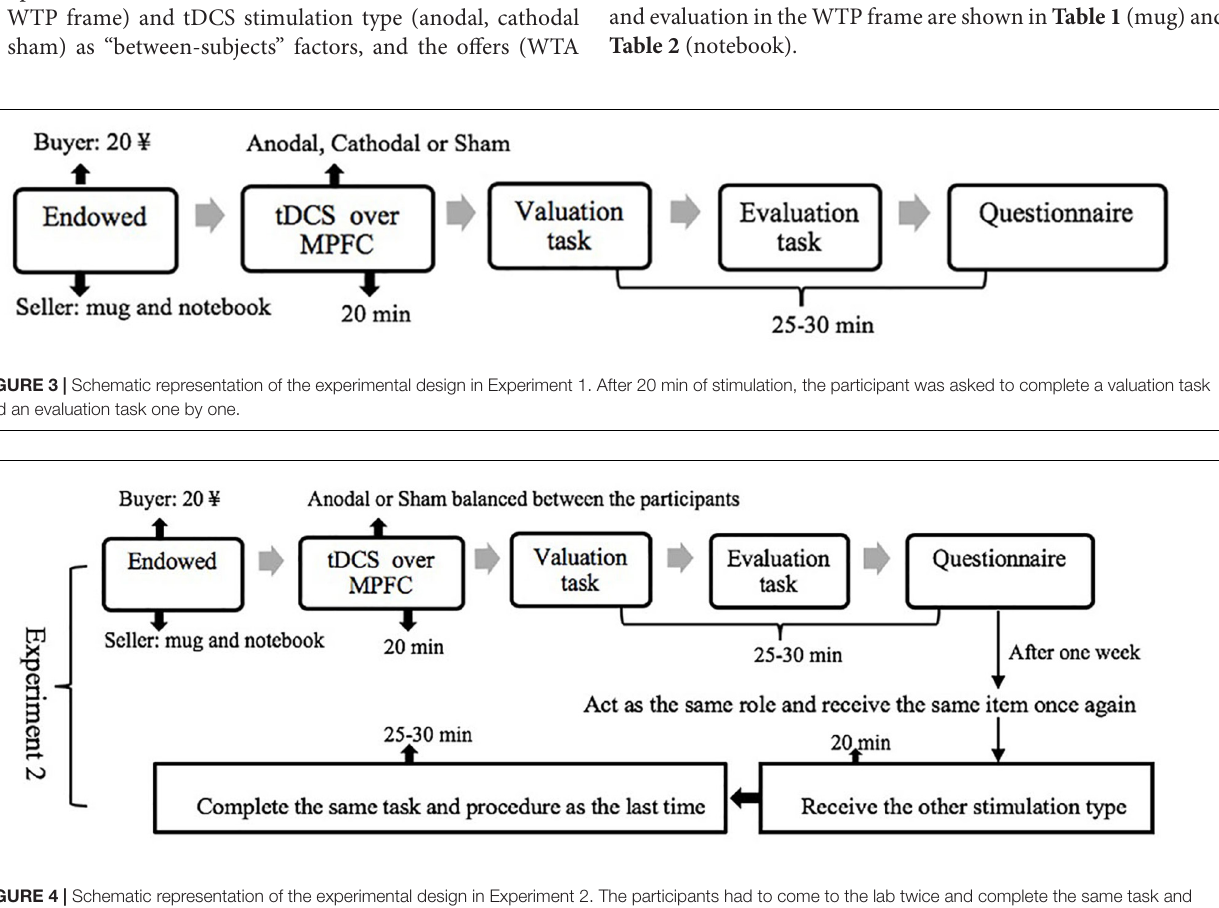
Frontiers in Behavioral Neuroscience |